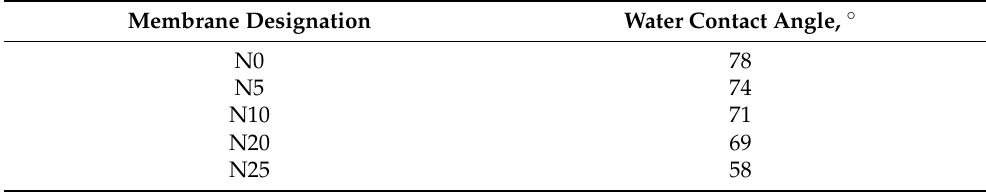
Table 3. Water contact angle of membrane selective layer